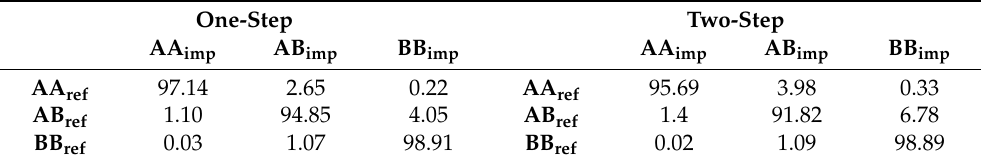
Table 2. Concordance rate in percentage between imputed sequence and real sequence of 136 animals for one-step (224 WGS reference) and two-step imputation (224 WGS and 991 700K